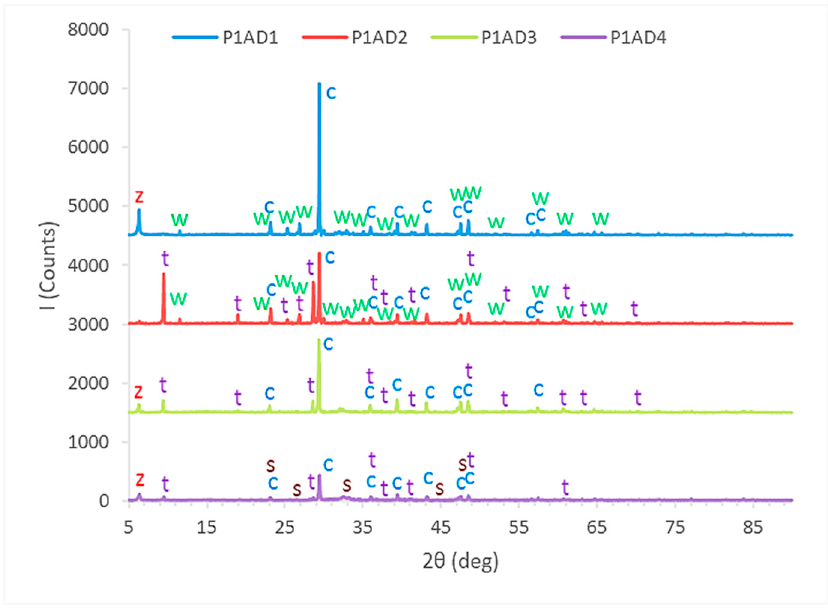
Figure 1. X-ray diffraction patterns of structural adhesives used in first phase. Figure 1. X-ray di ff raction patterns of structural adhesives used in first